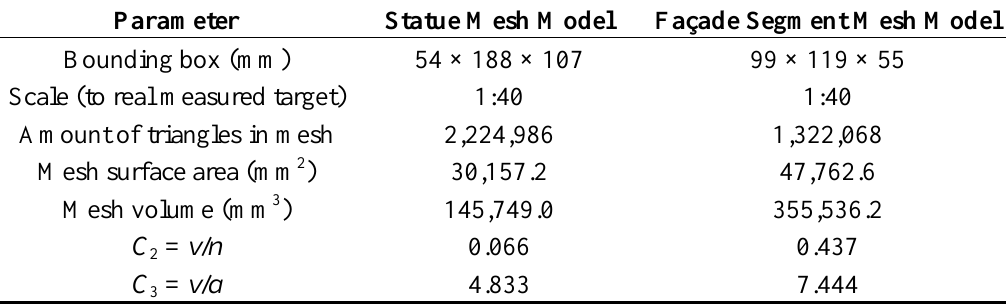
Table 2. Dimensions, scales and calculated complexity indexes of the created